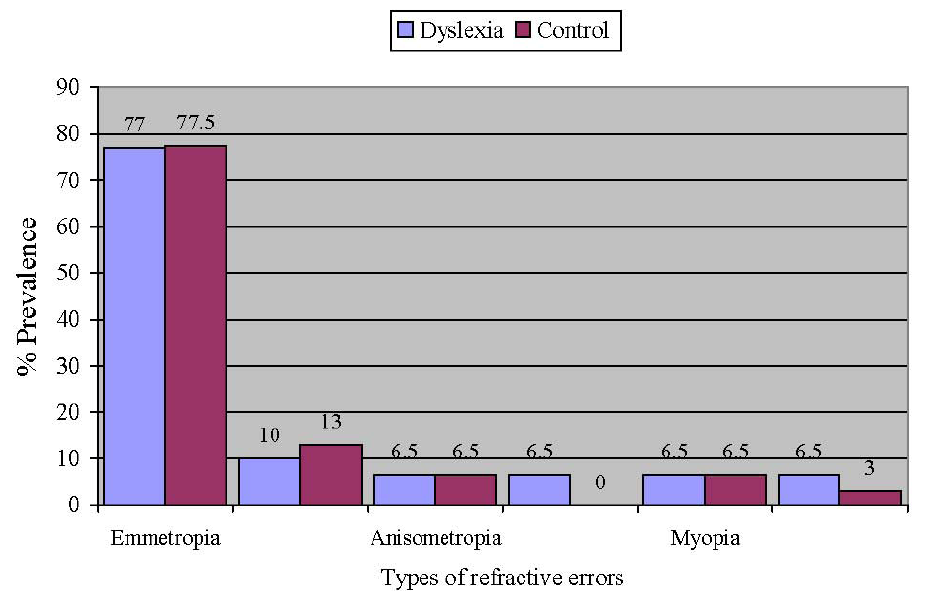
Figure 2 . Comparison of percentage prevalence of refractive errors in dyslexic and control groups. The prevalence of emmetropia was the highest and was similar in both groups, followed by